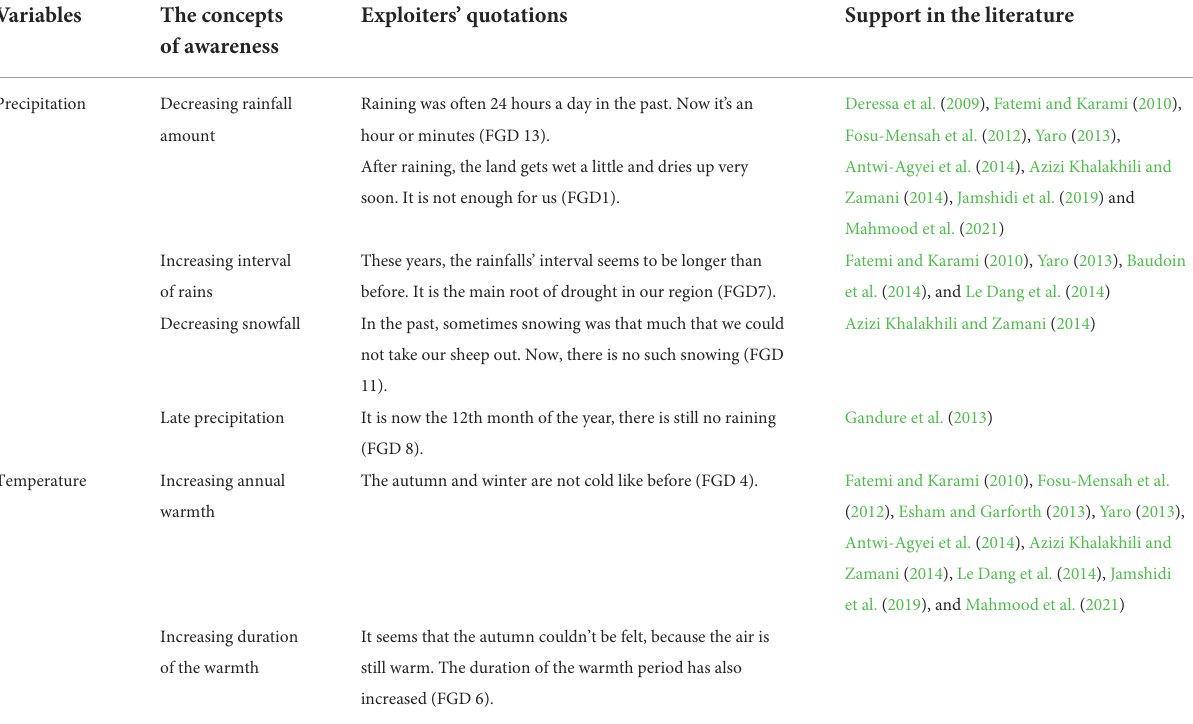
TABLE 1 Medicinal plant exploiters’ awareness about climate variability and